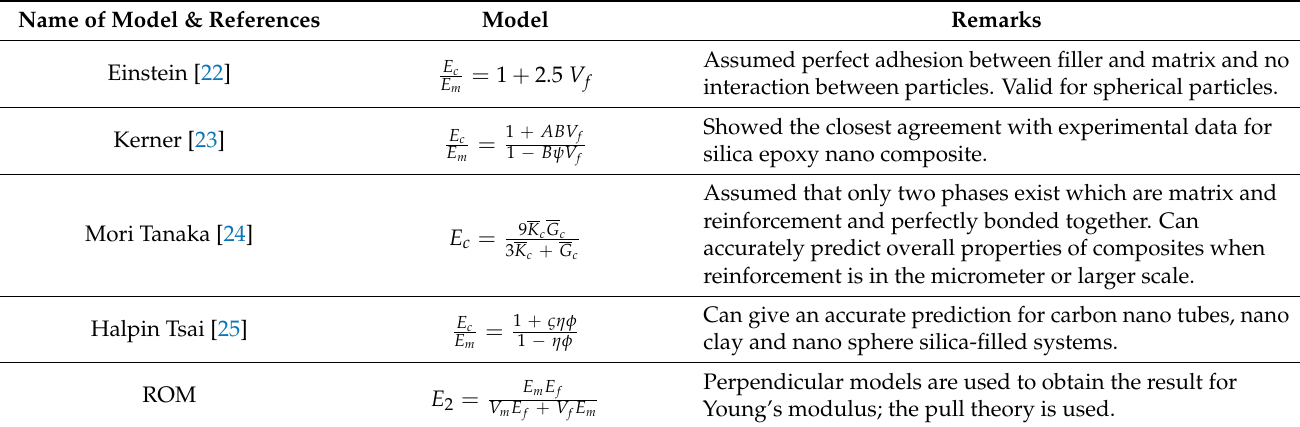
Table 4. Mori-Tanaka, Halpin-Tsai, Kerner and ROM models.